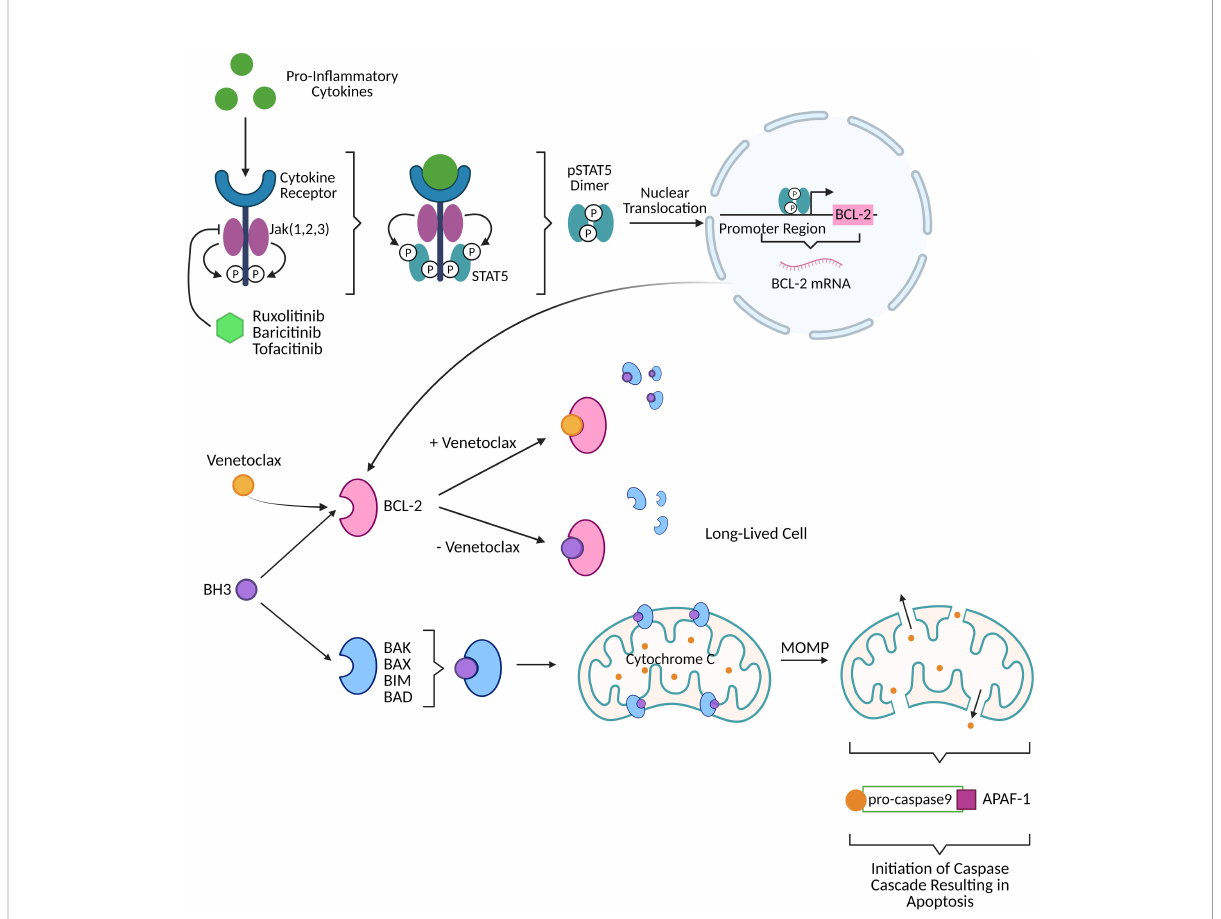
FIGURE 1 Activation of the Jak STAT pathway by pro-in fl ammatory cytokines (like those produced in viral infection) produces dimerized pSTAT5 that directly upregulates BCL-2, a pro-survival factor, resulting in long-lived cells harboring HIV-1 DNA. FDA approved Jak inhibitors (ruxolitinib, baricitinib, tofacitinib) can block the BCL-2 cascade upstream. Venetoclax, FDA approved BCL-2 selective BCL-2 homology 3 (BH3) mimetic, prevents BCL-2 sequestration of BH3. Free BH3 is then able to interact with pro-apoptotic proteins (BAK, BAX, BIM, BAD) to perform mitochondrial outer membrane permeabilization (MOMP) thereby releasing cytochrome C. Cytochrome C interacts with pro-caspase9/ apoptotic protease activating factor 1 (APAF-1) to initiate a caspase cascade that culminates in apoptotic cell death. Created with